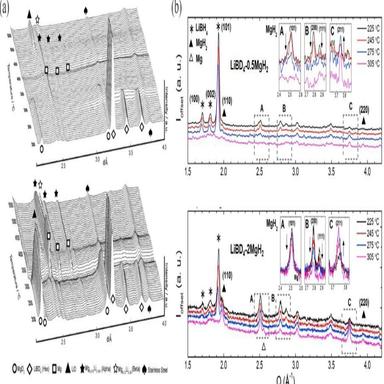
In situ neutron diffraction patterns of 2:1 (top) and 0.3:1 (bottom) LiBD4-MgD2 samples during decomposition under a dynamic vacuum; (b) Neutron diffraction patterns of LiBD4-0.5MgH2 and LiBD4-2MgH2 at various temperatures under 1 bar He. The inset figures are magnified views of the Bragg peaks of MgH2 in the grey boxes.